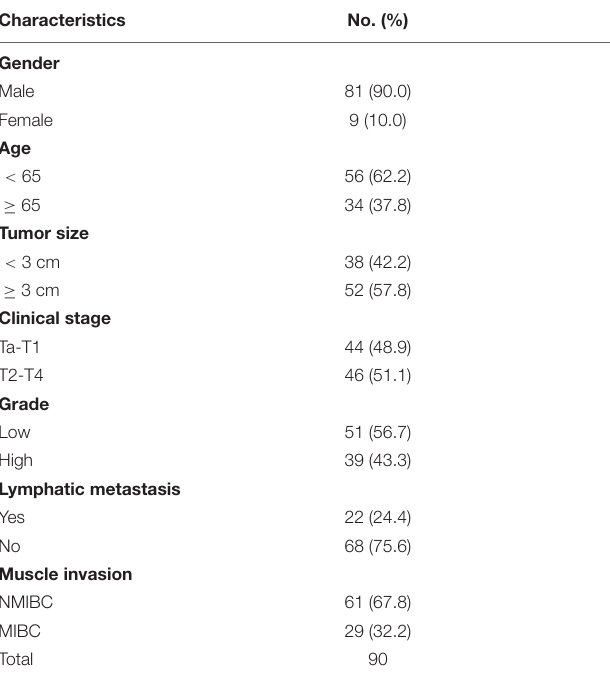
TABLE 4 | Clinicopathological features in Tissue Microarray of 90 pairs of bladder cancer.